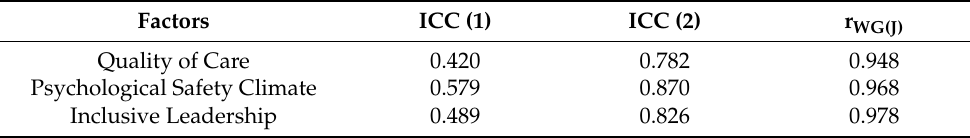
Table 4. Overall aggregation